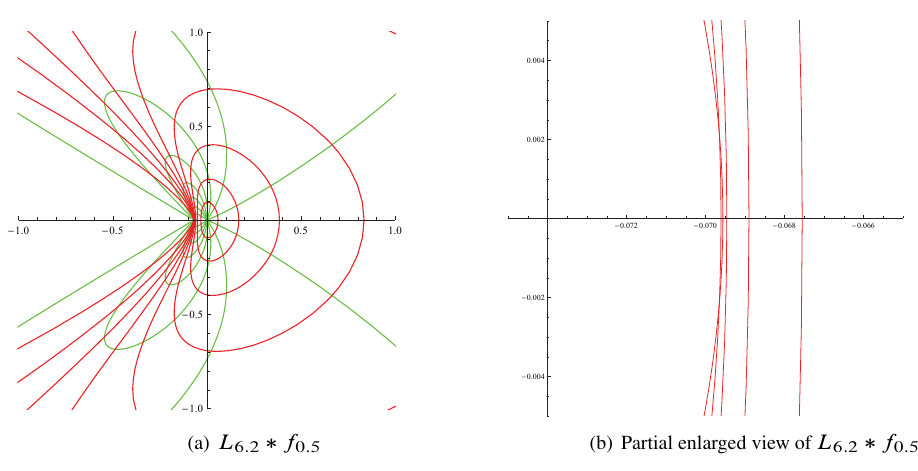
Fig. 4. Images of the unit disk U under L 6:2 (cid:3) f 0:5